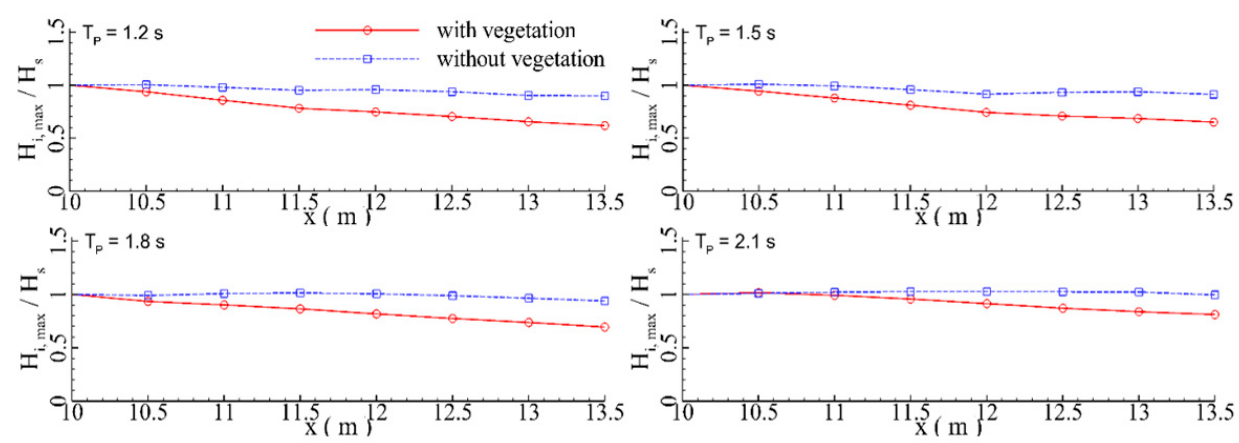
Figure 21. Spatial distribution of local maximum wave height under peak wave periods.